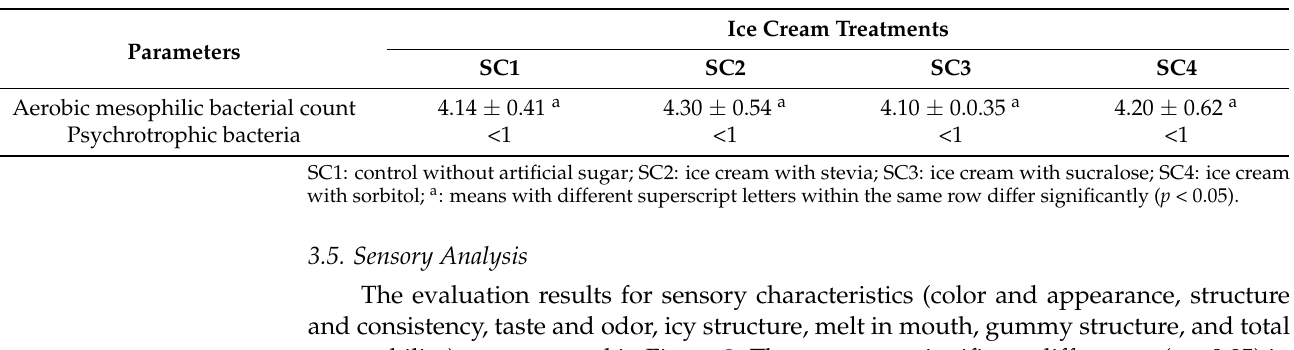
Table 5. Microbiological analyses (log 10 CFU g − 1 ) of ice cream treatments (means ± SE). Parameters